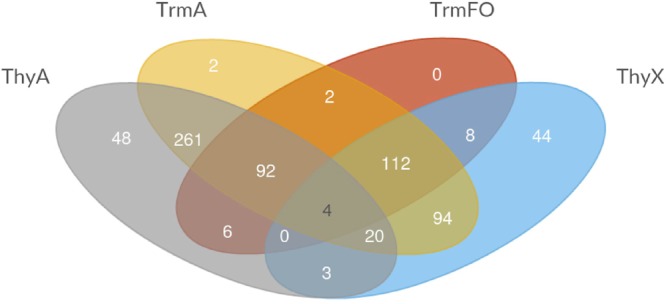
Venn diagram depicting the different combinations of thymidylate-forming enzymes ThyA, ThyX, TrmA, and TrmFO in the species included in the COG database (Galperin et al., 2017).